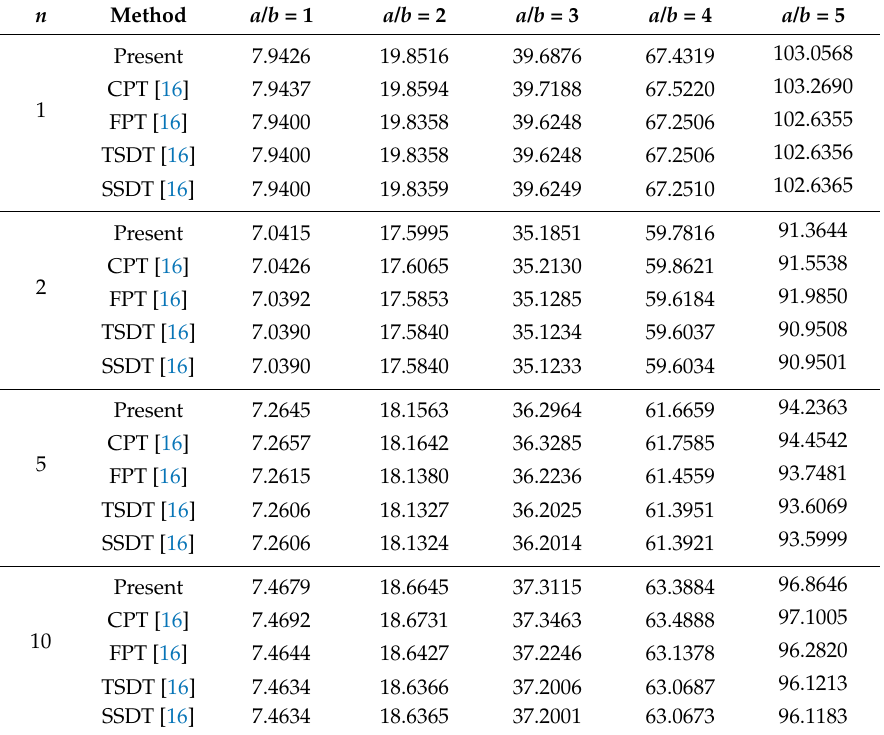
Table 6. Critical buckling temperature ∆ T cr of SSSS type-II FGM plate with different a / b under a uniform temperature field ( a / h = 100).